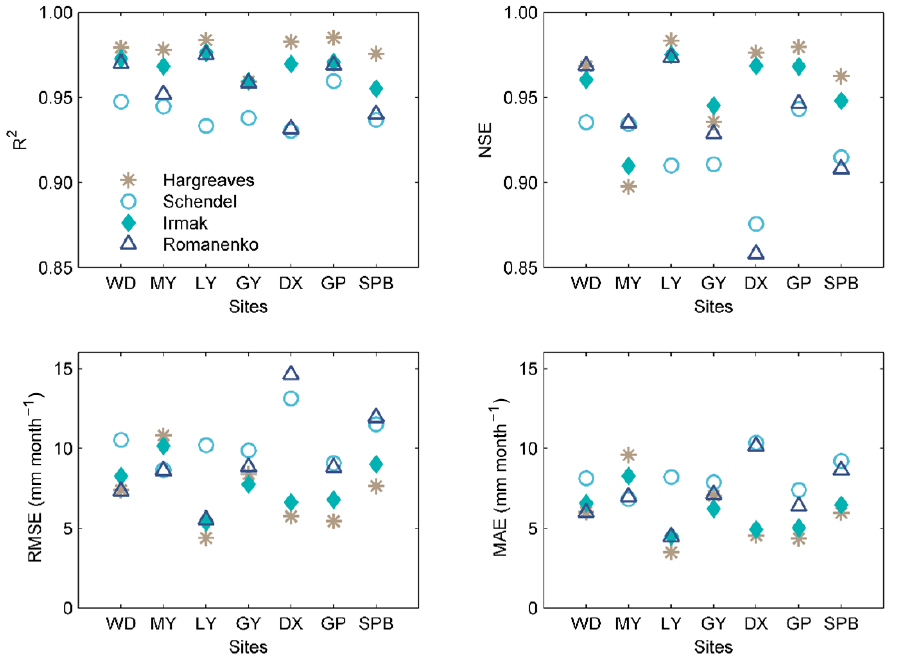
Figure 3. Statistical indices of the four calibrated empirical equations at the seven stations for modeling ET 0 during the testing period (2008–2014). WD-Wudu, MY-Mianyang, LY-Lveyang, GY- Guangyuan, DX-Daxian, GP-Gaoping, SPB-Shapinba.